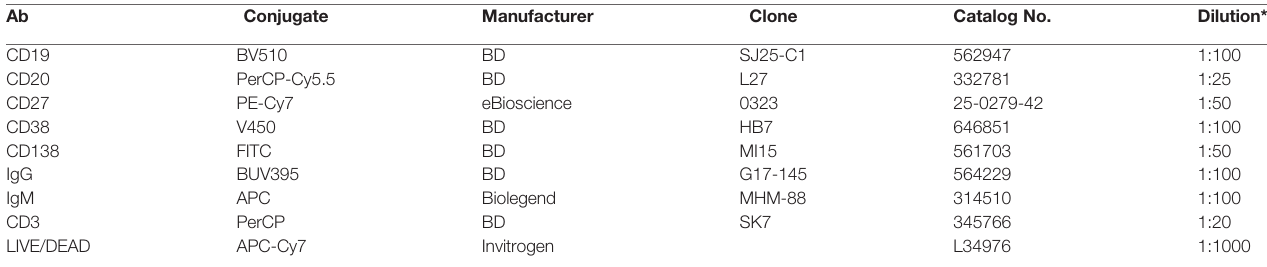
TABLE 2 | Antibodies used for fl ow